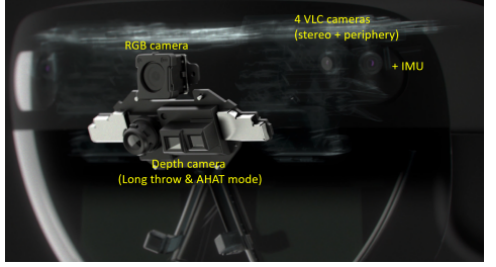
Figure 2. The Hololens 2 research mode sensors including RGB and far-depth cameras (Ungureanu et al., 2020)